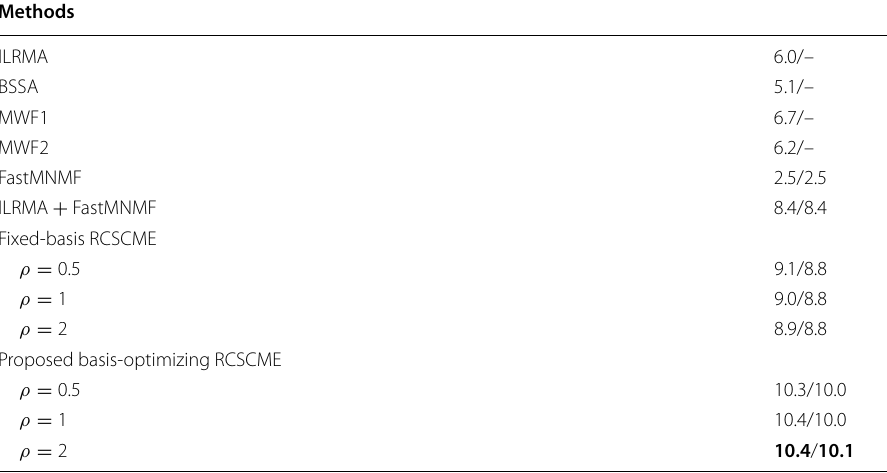
Each term represents “best‑iteration score [dB]/after‑200‑iteration score [dB].” Bold text indicates the maximum